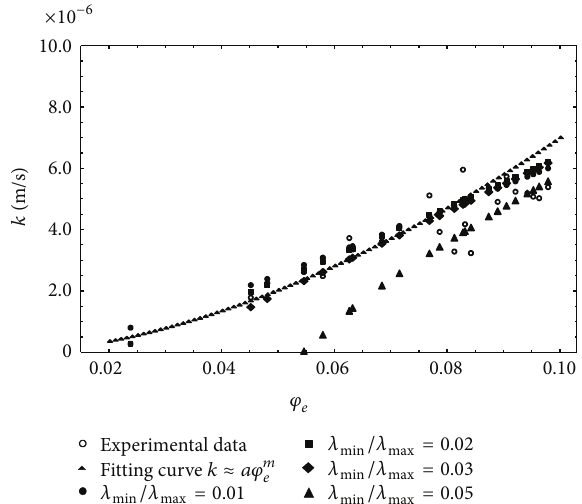
Figure 7: Fitting curves: for experimental and Xu and Yu [36]